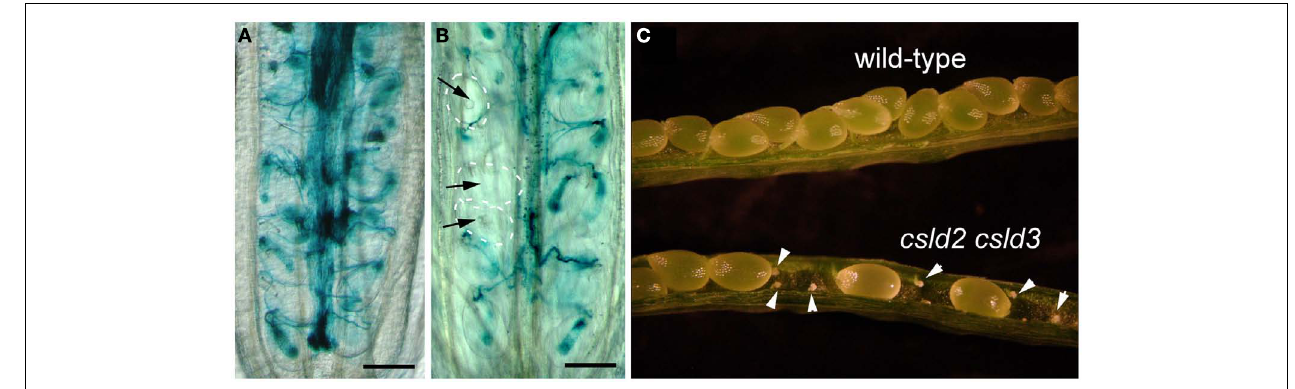
other hand, all of the wild-type ovules show pollen penetration. (C) Dissected view of mature siliques. Note that siliques of the csld2 csld3 double mutant contained unfertilized and desiccated ovules (white arrowheads), while the wild-type produces a complete set of seeds. Bars = 100 μ m (A,B) .